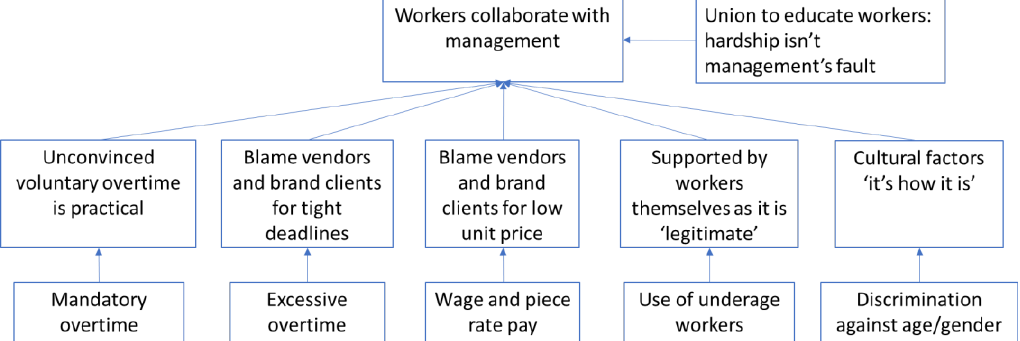
Figure 3. Reasons workers collaborate with management to hide non-compliance practices.